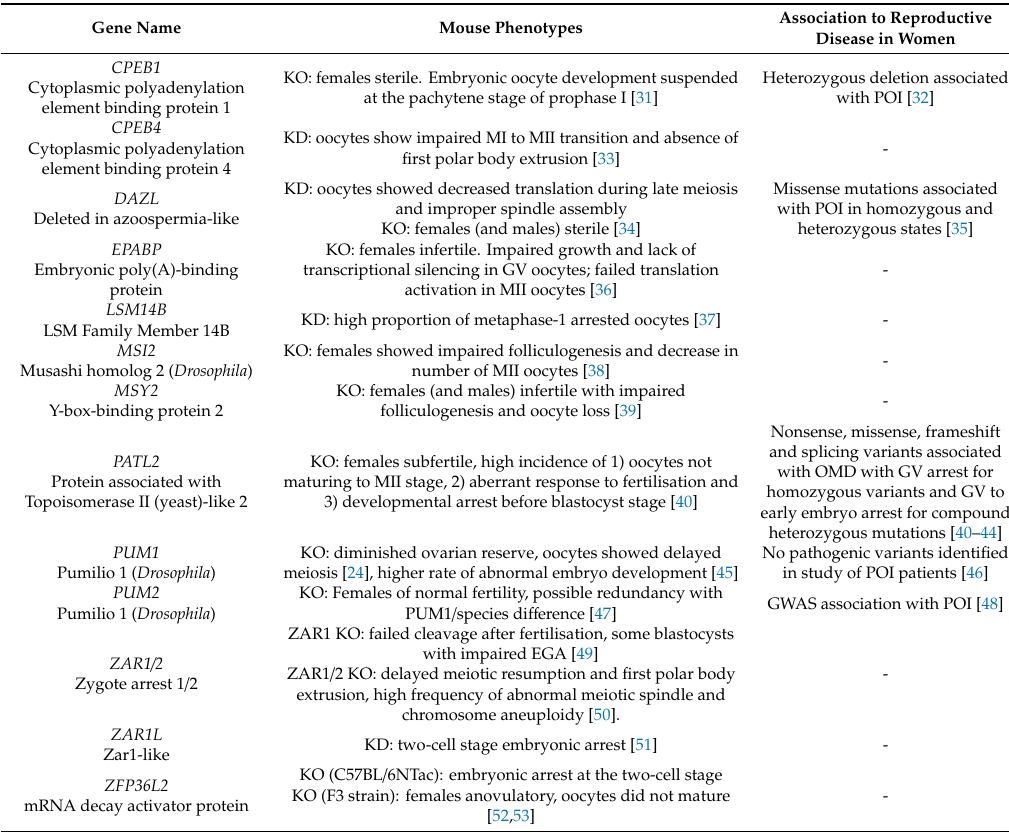
Figure 6. Germ-cell granules or ‘P-bodies’ in young mouse oocytes and a sub-cortical mRNA storage domain in growing / mature oocytes. Confocal images of mouse oocytes from 2 days postpartum (dpp) and 12 dpp females, immature NSN (non-surrounded nucleolus) and mature SN (surrounded nucleolus) GV oocytes, MII oocytes, and cumulus cells from adult females after staining with 18,033 (stains P-body protein EDC4), DCP1A, and DDX6 antibodies. Diagonal arrowheads depict P-bodies and horizontal arrowheads depict subcortical aggregates. Dashed lines border the subcortical domain. Staining with 18,033 is green, other proteins are red, and DNA staining in blue. Scale bars: 10 µ m. Source: Flemr et al., 2010 [28]. Table 1. Mammalian oocyte RNA-binding proteins (expressed in maturing oocytes) with corresponding transgenic mouse phenotypes and any association of gene variants with human reproductive disease (female). POI: Primary ovarian insu ffi ciency, OMD: Oocyte Maturation Deficiency, GWAS: Genome-wide association